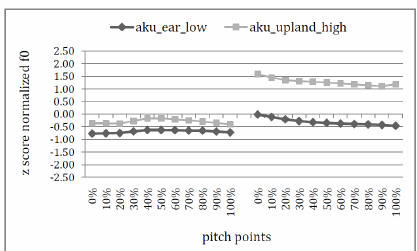
Figure 9: Normalized pitch contours for [aku], (n=20{5 speakers*4 iterations each})